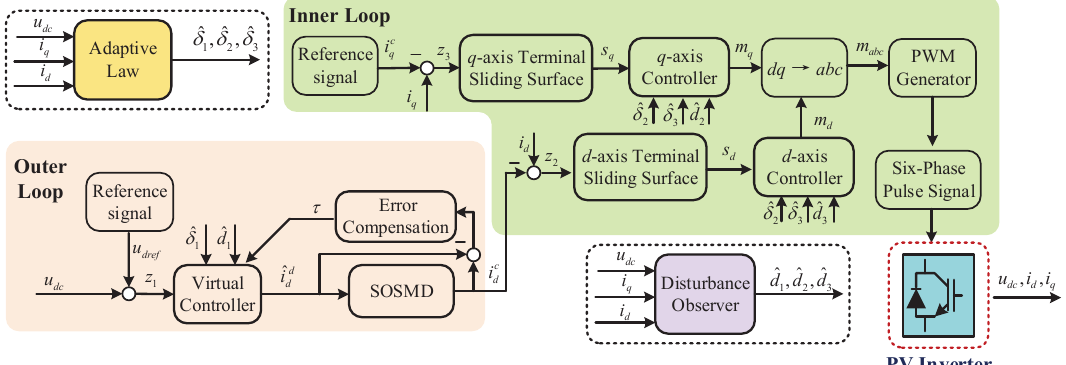
Figure 3. Block diagram of disturbance finite-time adaptive sliding mode backstepping (DFA-SMB) controller for PV